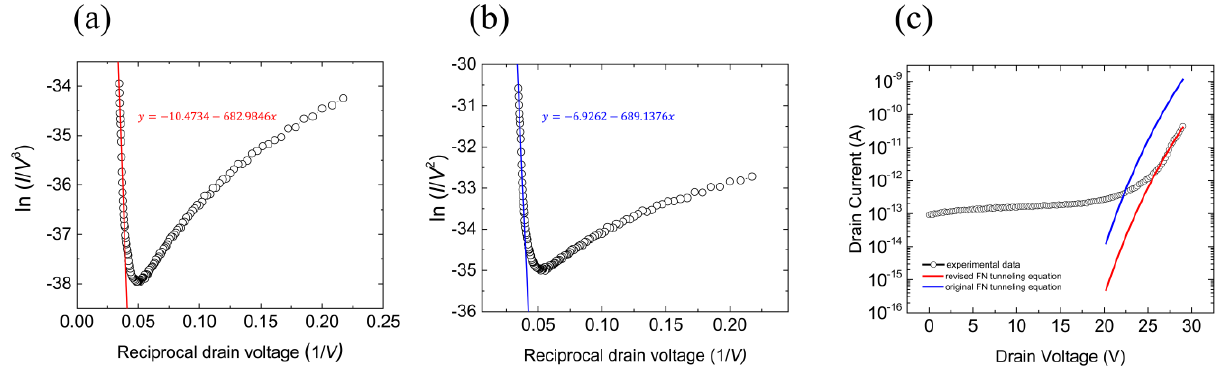
Figure 2. Fitting of FNT to calculate the tunneling barrier height with the revised and traditional equations. ( a ) Straight line (red) fitted to FNT current by the revised FNT equation. Its slope is estimated to be − 683 V. A barrier height of 2.10 eV was extracted from the slope. ( b ) Straight line (blue) fitted to the FNT current by the traditional FNT equation. Its slope was estimated to be − 689 V. A barrier height of 2.11 eV was extracted from the slope. ( c ) The experimental I D – V D curve (black) of FEB consisting of graphene and hBN, the simulated I–V curve by the revised FNT equation (red), and simulated I D – V D curve by the original FNT equation (blue). Further information of fitting method is explained in detail on Appendix